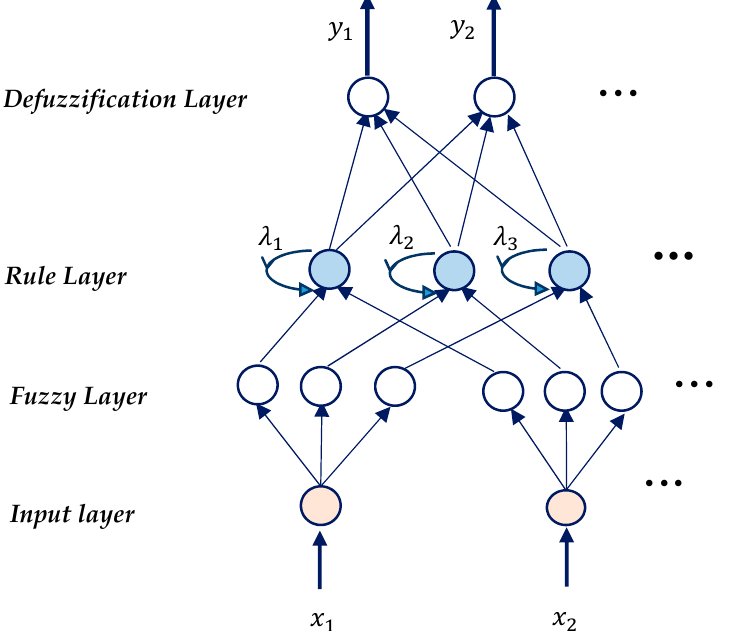
Figure 8. The structure of a recurrent fuzzy neural network. x and y represent input and output vectors, respectively. λ i in the rule layer represents the recurrent parameter.